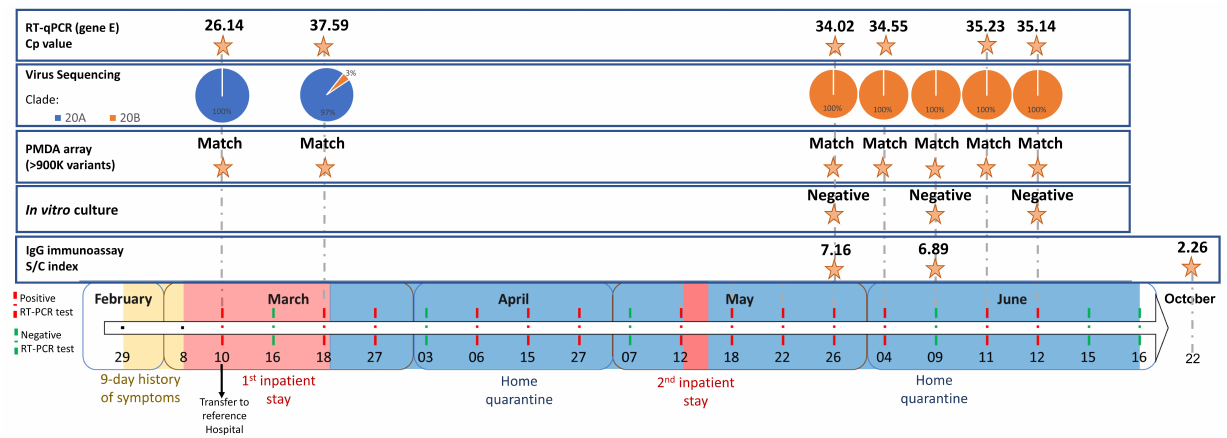
Figure 1. Timeline of the reported coronavirus disease 2019 (COVID-19) case and main results of the multi-component study conducted on the serial samples. The timeline bar indicates the periods of: symptom onset (yellow); inpatient stays (pink; the black arrow indicates the moment when the patient was transferred to the referral center for Emerging Infectious Diseases at Centro Hospitalar Universit á rio de S ã o Jo ã o—CHUSJ); and, home quarantine (blue). It also includes the dates of all the 19 RT-PCR tests performed (green for negative result and red for positive result). The molecular tests were focused either on the virus (RT-PCR crossing point, proportion of clade/lineage affiliation inferred from viral whole-genome sequencing, and in vitro culture) or the host (array containing > 900 K variants and IgG antibody immunoassay reported as sample/calibrator relative light unit